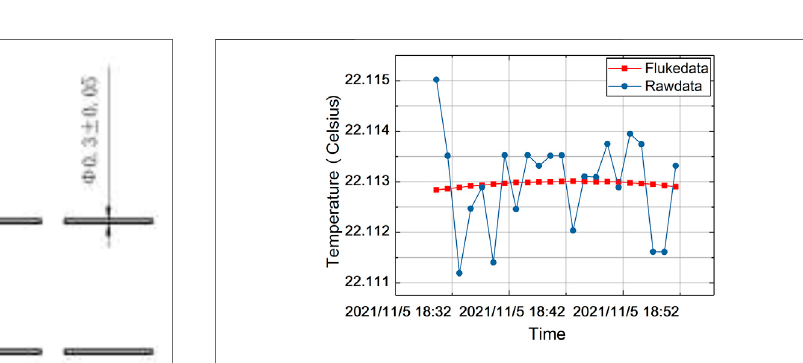
FIGURE 8 | Local enlargement of experimental test data.